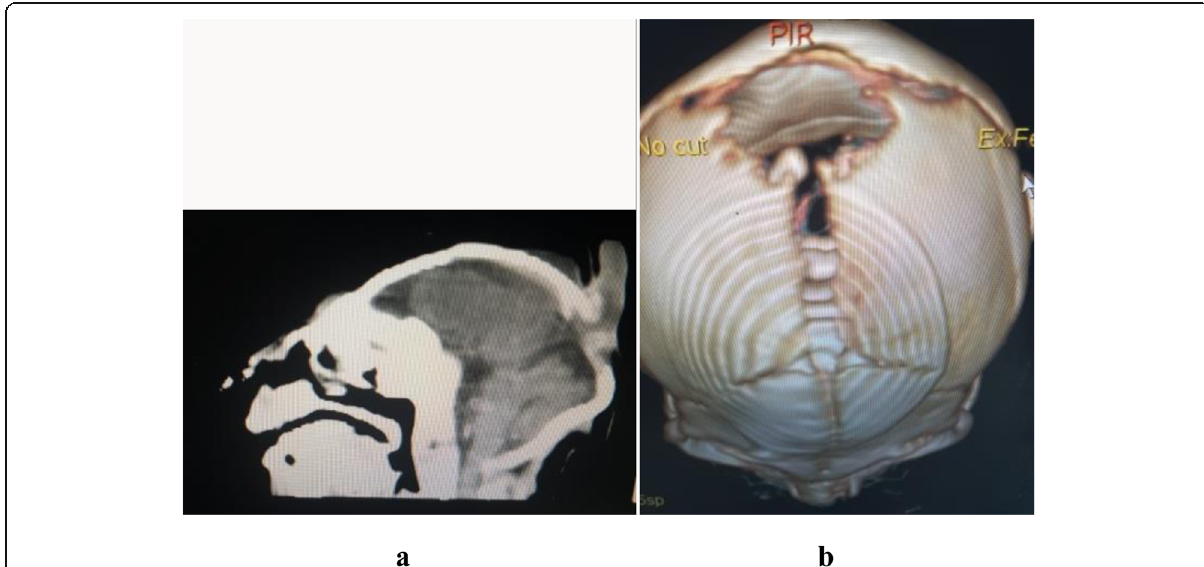
Fig. 3 A female infant with microcephaly. a Sagittal CT brain with IV contrast showing occipital encephalocele with abnormal shape small size skull, the corpus callosum cannot be detected. b 3D bone window reconstruction shows a posterior parieto-occipital midline bony defect